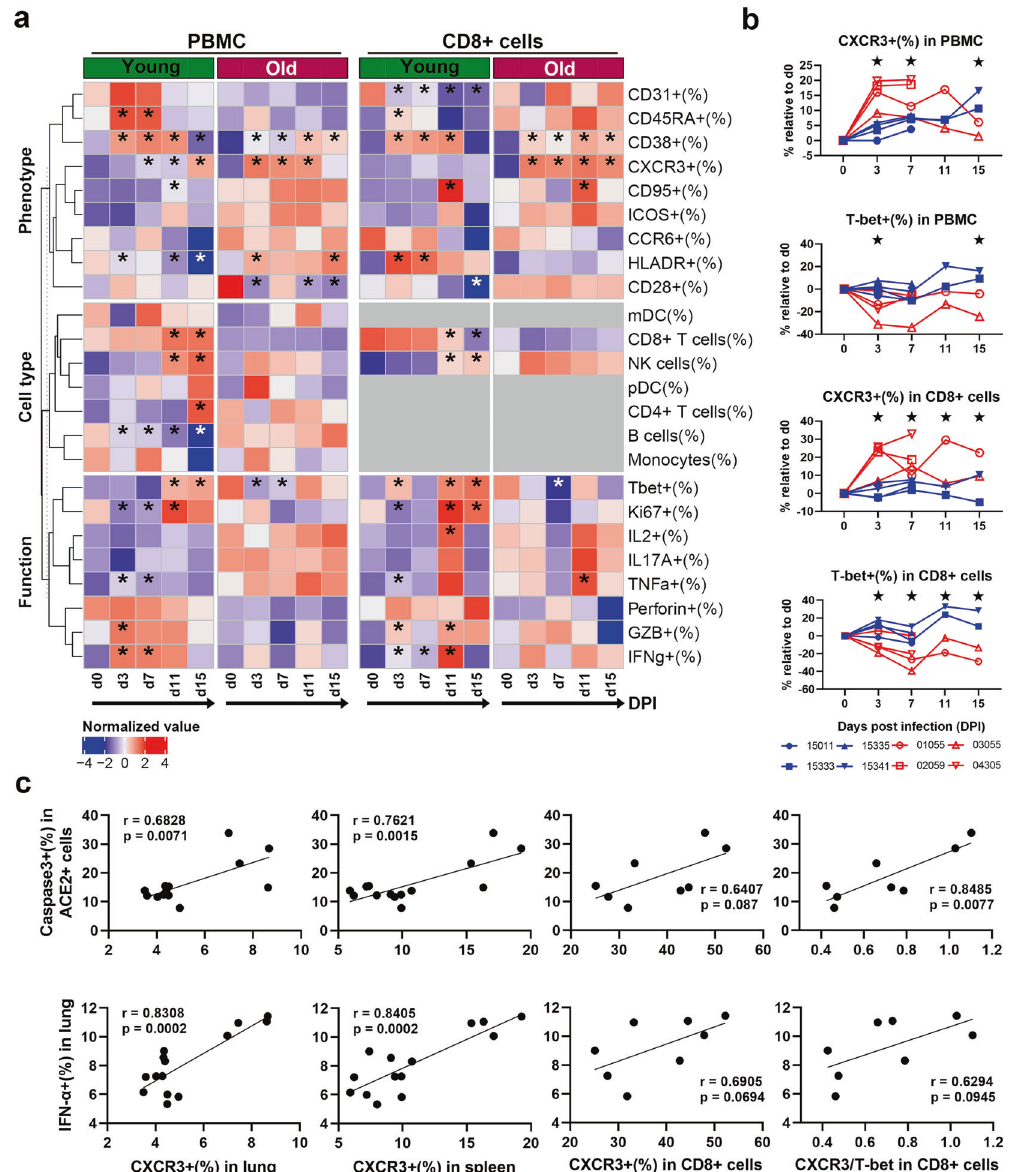
Fig. 6 Systemic increase in CXCR3 + cells of SARS-CoV-2-infected old RMs is associated with the in fl ammatory microenvironment. a Heat map showing changes in frequency of immune cell type-, phenotype-, and function-related cell subsets in PBMCs and peripheral blood CD8 + cells from young ( n = 4) and old RMs ( n = 4) at 15 days after SARS-CoV-2 infection. An annotation bar indicates the age group of each sample. The average frequency was mapped by a red-white-blue gradient square. * p ≤ 0.05 compared with d0. b Changes in frequency of CXCR3 + or T-bet + subsets in PBMCs and CD8 + T cells relative to d0 after infection in young and old RMs, shown as line graphs. * p ≤ 0.05 for comparison between young and old RMs at a time point. c , d Correlations between levels of CXCR3 + or T-bet + cells in lungs, spleens, PBMCs, and CD8 + T cells and levels of IFN- α + ( c ) and IL-6 + ( d ) cells in lung tissue are shown as scatter diagrams with linear regression curves. Dots represent each animal; r Pearson correlation coef fi cient, p Pearson correlation signi fi